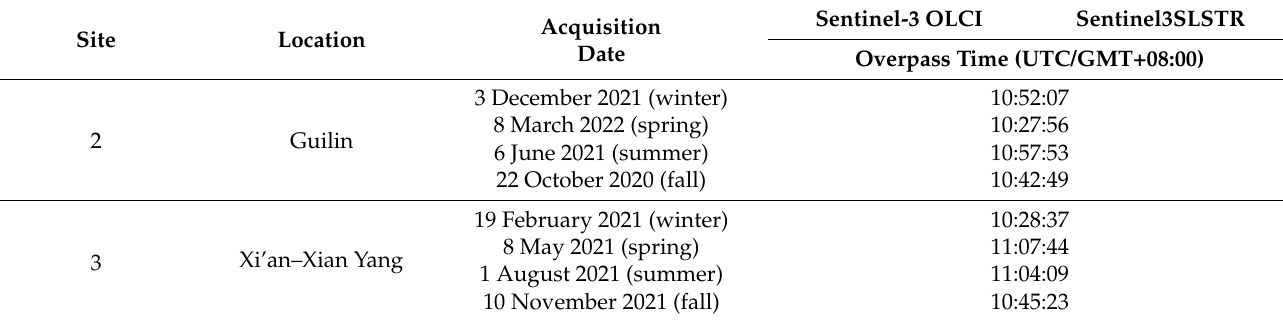
Table 2. List of Sentinel-3 images used in site 2 and site